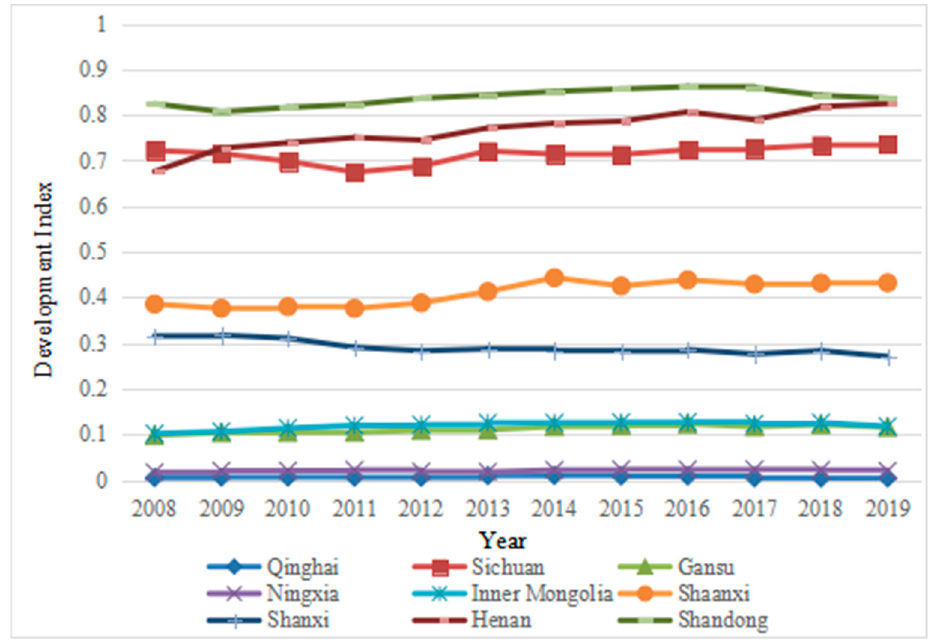
Figure 2. Development Status of Public Service in the Yellow River Basin from 2008 to 2019.